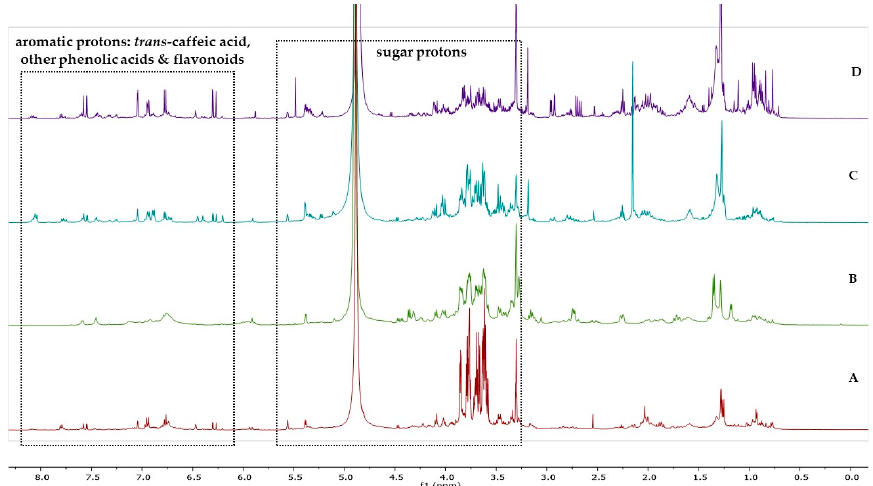
Figure 1. 1 H-NMR spectra of hydromethanolic extracts of ( A ) leaves, ( B ) twigs, ( C ) flowers, and ( D ) young fruits of A. ovalis subsp. ovalis genotype GR-1-BBGK-04,2547 (CD 3 OD, 500 MHz). Signals between 6.20–8.10 ppm correspond to aromatic protons of caffeic acid, other phenolic acids, and flavonoids, whereas signals between 3.20–5.55 ppm are attributed to sugar protons.